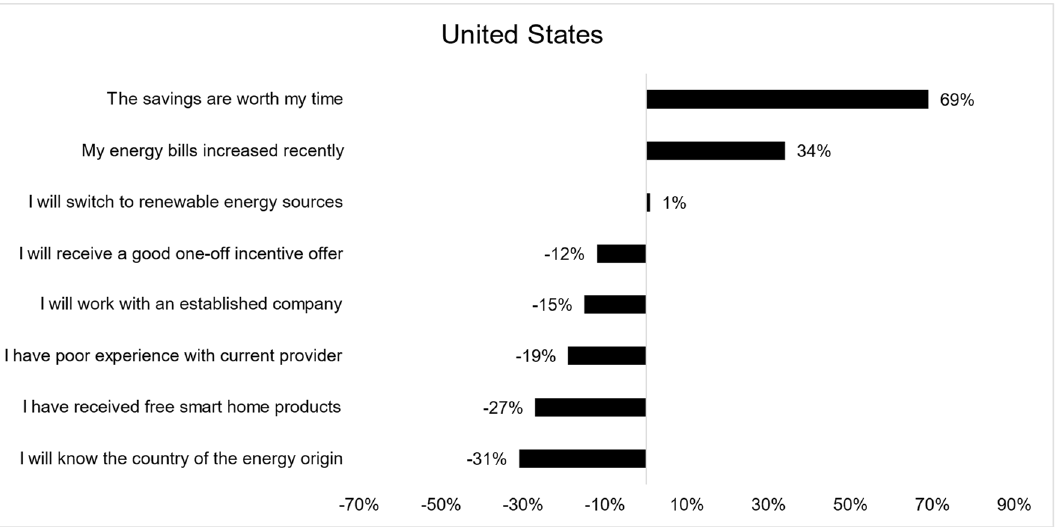
Figure 4. Utility attributes for various energy provider reasons in the United States . Source: own study.